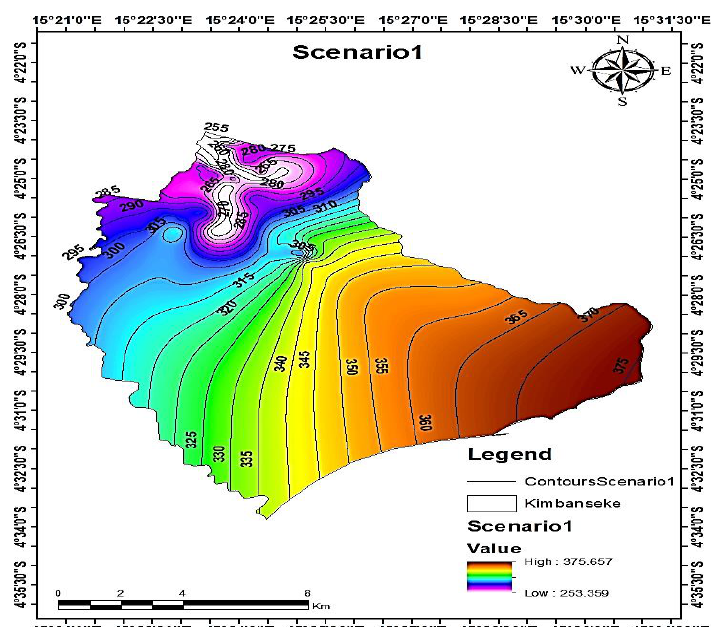
Figure 19. Scenario 1.